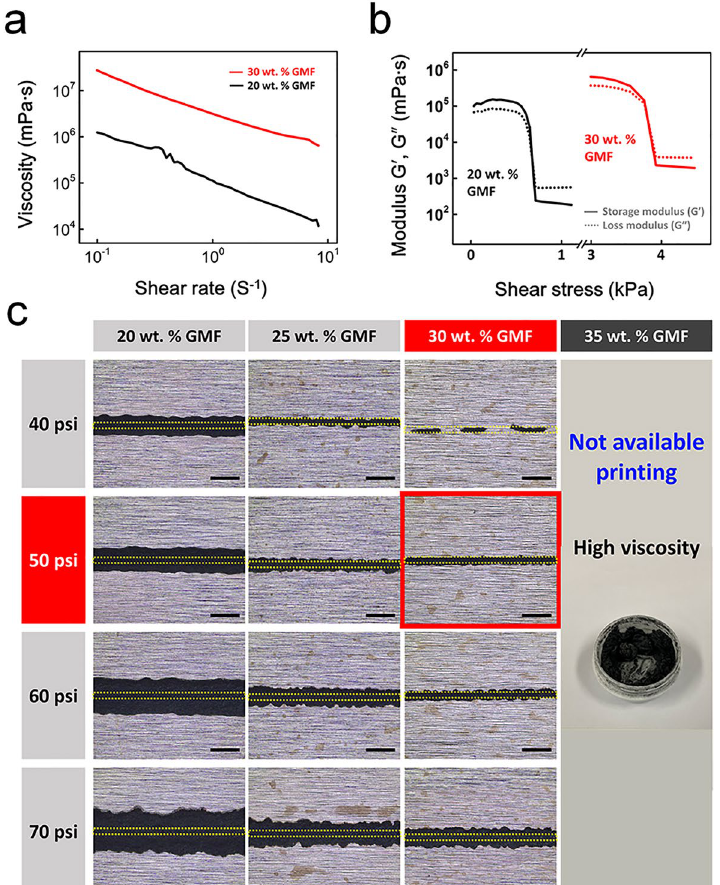
Figure 2. Rheological properties and printability of graphene inks. (a) Viscosity vs. shear rate. (b) Storage (G ′ ) and loss (G˝) moduli vs. ink shear stress. (c) Ink printability as a function of GMF concentrations. Scale bar: 500